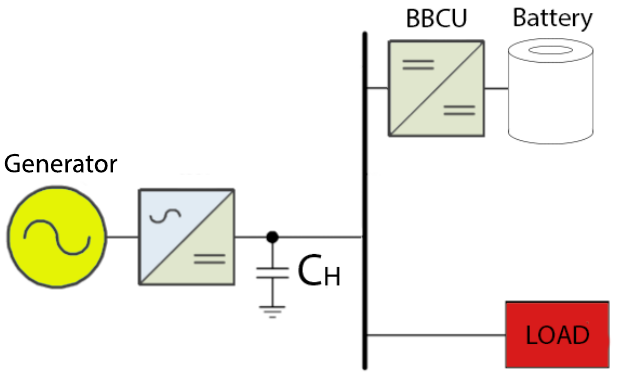
Figure 1. Basic energy management configuration of Aircraft.